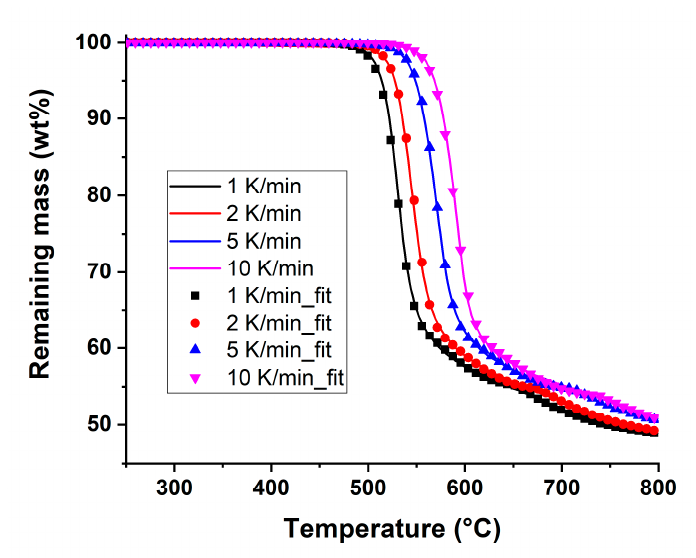
Figure 7. Best fit of the TG data for the three-step reaction models in Scheme 1, with the parameters given on Table 2. The curves represent the experimental data and the symbols represent the model.